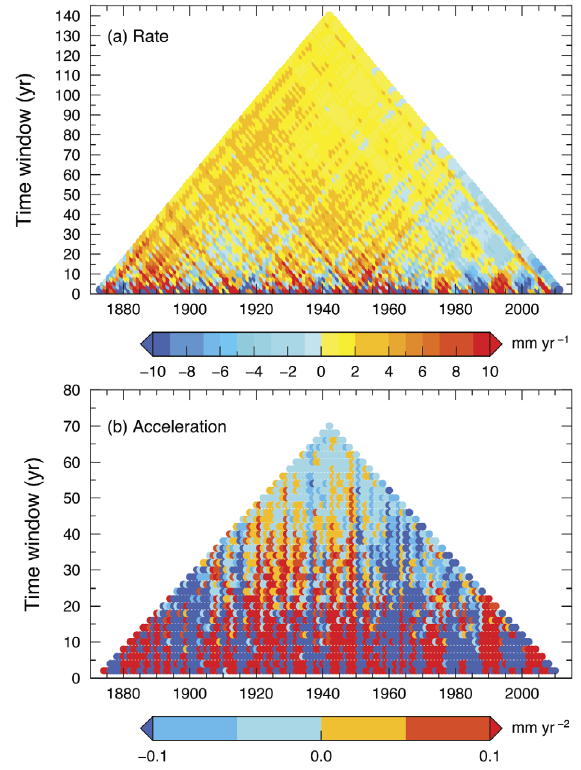
Figure 3. MSDA for the rate of sea-level change in (a) and acceler- ation (b) obtained by differencing the AS curve of Figure